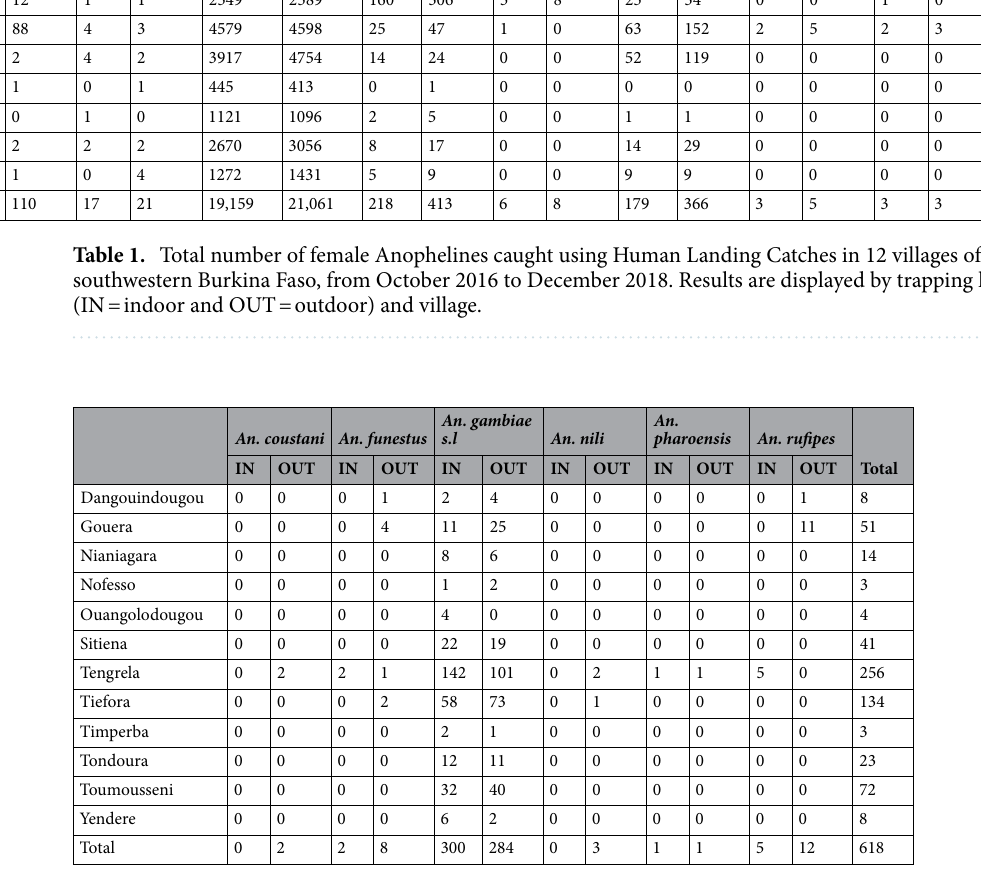
Table 2. Total number of female Anophelines caught using Resting Bucket Traps in 12 villages of southwestern Burkina Faso, from October 2016 to December 2018. Results are displayed by trapping location (IN = indoor and OUT = outdoor) and